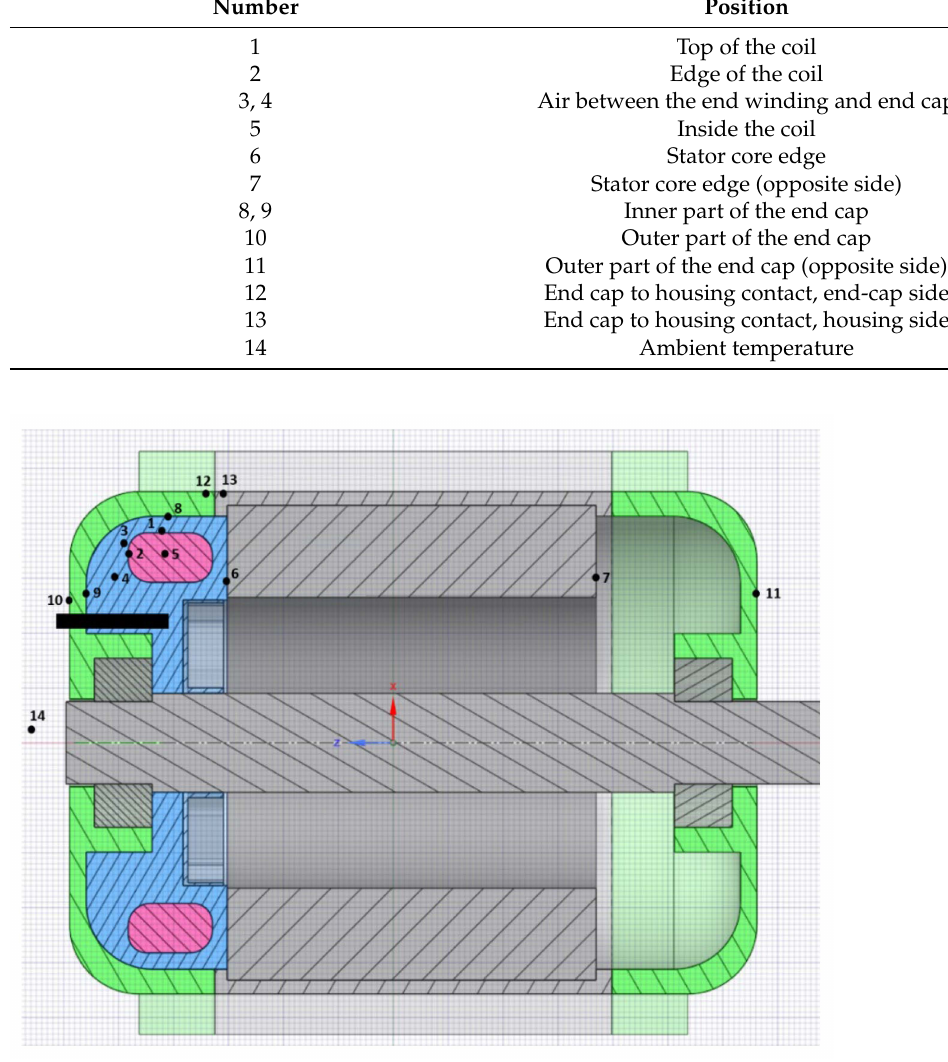
Figure 4. Position of the thermocouple sensors for measuring temperatures. The black rectangle represents the position of the